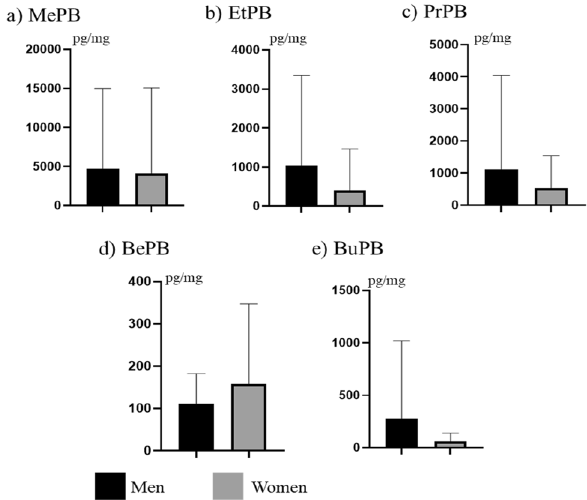
Figure 2. Mean concentration levels (± SD) of parabens in hair of men and women.